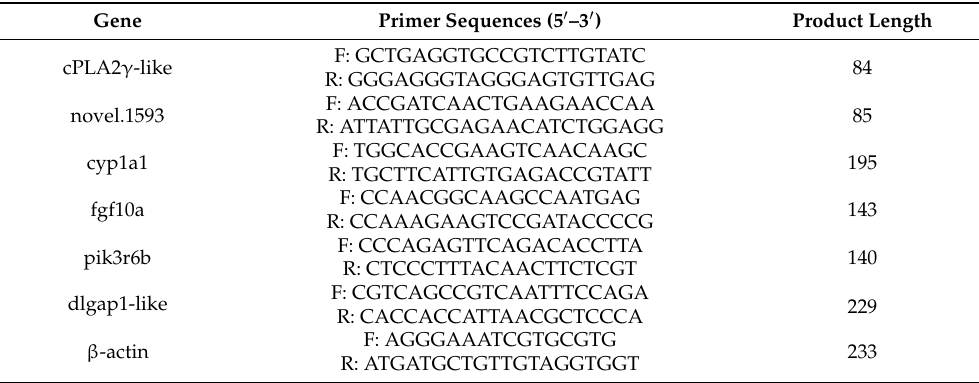
Table 1. Primer sequences of differentially expressed genes under salinity stress were verified by qRT-PCR.